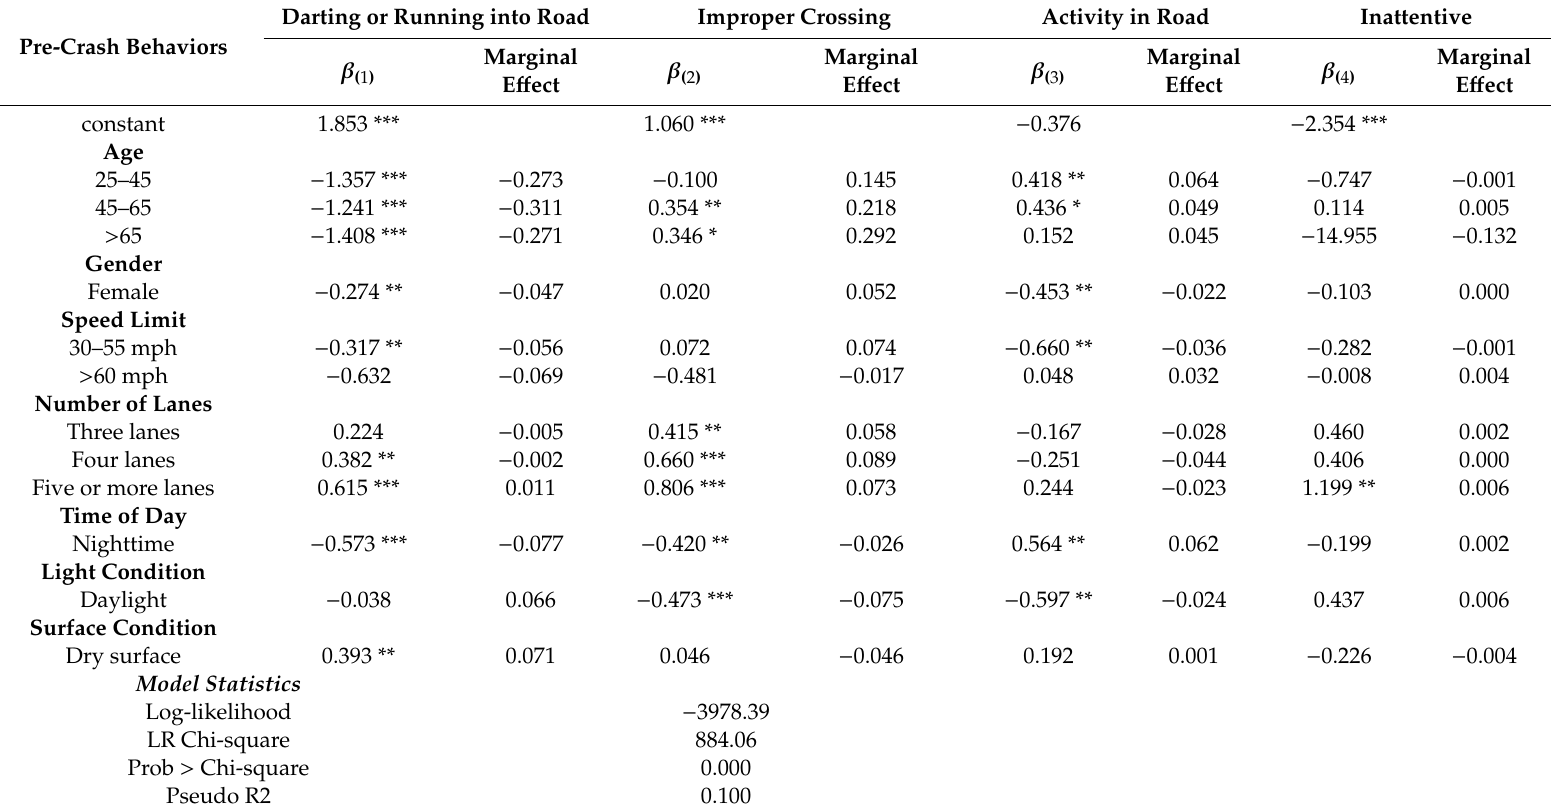
Table 2. Results of the multinomial logit model for pre-crash behavior of the